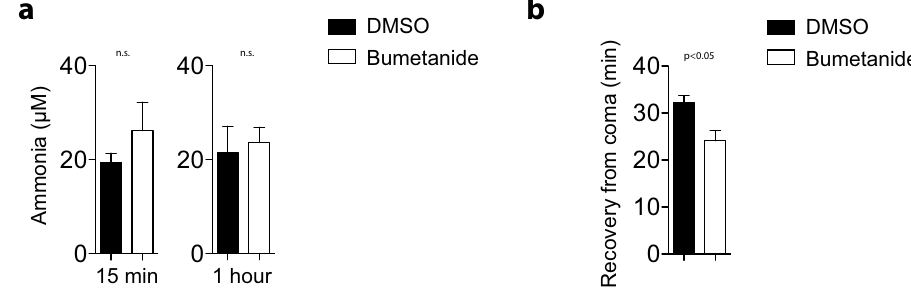
Figure 7. Inhibition of NKCC1 alleviates acute ammonia toxicity. (a) Ammonia concentrations were measured from retro-orbital venous sinus after i.p. injection of 30 mg/kg bumetanide (n = 5). (b) C57Bl/6 animals were treated intraperitoneally with either 30 mg/kg Bumetanide or vehicle. After 5 minutes 14 mmol/kg ammonium acetate in PBS was injected intraperitoneally followed by measurement of the duration of intoxication (time until recovery from coma) (n =